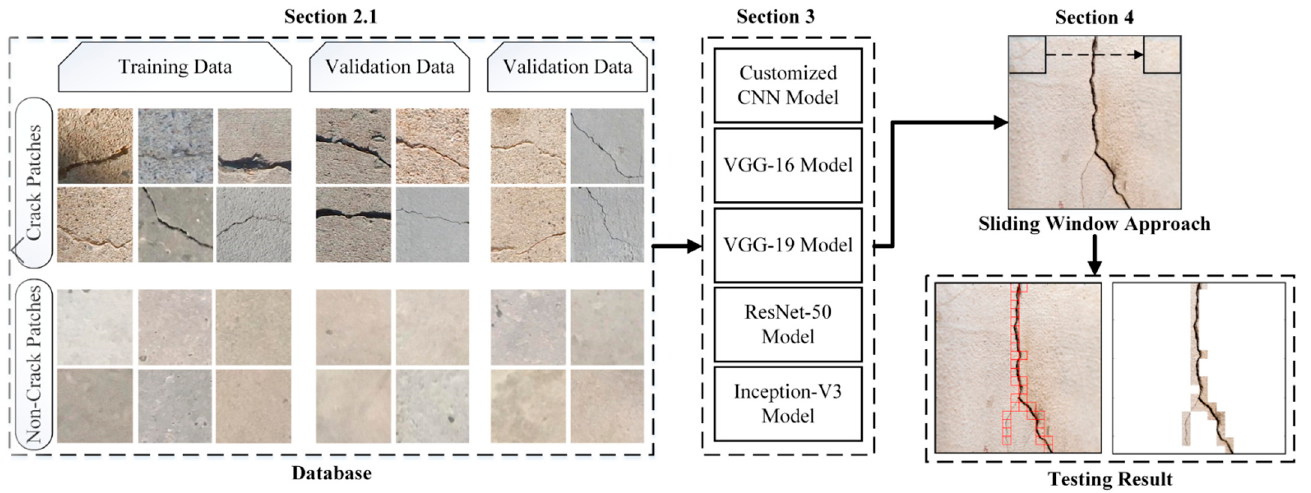
Figure 1. Outline of proposed work.